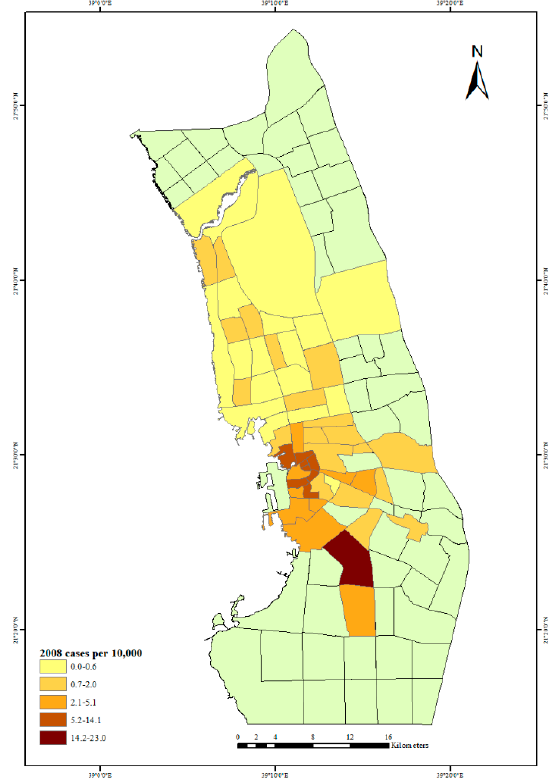
Figure 5. Dengue fever cases per 10,000 people in Jeddah City, 2008.